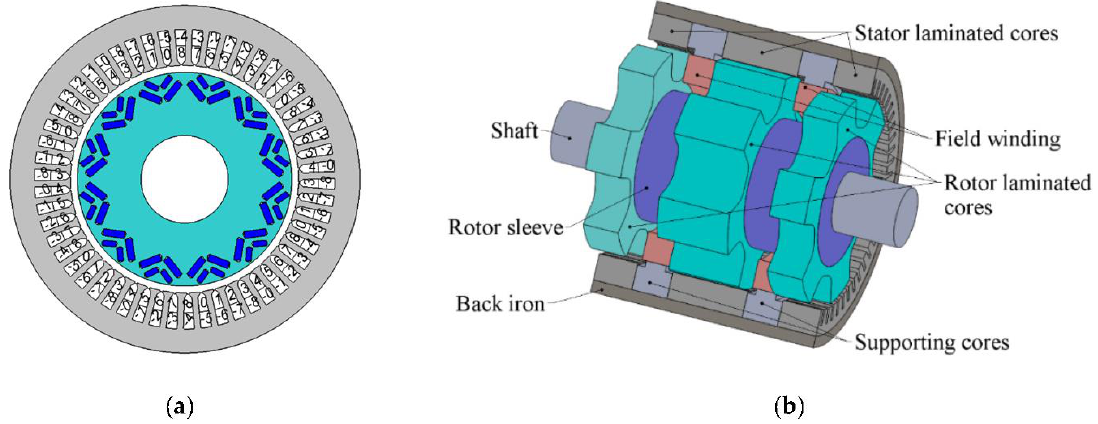
Figure 1. Sketch of the machine geometry: ( a ) interior permanent magnet synchronous motor (IPMSM); ( b ) homopolar synchronous motor (SHM).